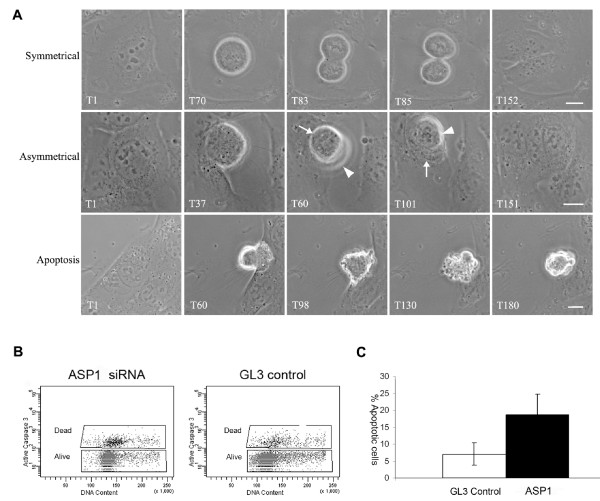
siRNA mediated ASPM induces misorientation of the plane of cell division, cytokinesis failure and increased apoptosis in U2OS cells. A. Panels showing phase contrast images of living U2OS cells taken from time-lapse movies. Time points are shown in the bottom left hand corner of each image. Top row. Normal symmetrical division of a GL3 siRNA treated control cell with the cleavage plane oriented perpendicular to the cell substrate (see Additional file 5). Scale bar = 10 μm. Middle row. ASP1 siRNA treated cell undergoing an asymmetric division with the mitotic spindle positioned perpendicular to the cell substrate. This division led to cytokinesis failure with the formation of a binucleate cell. Arrowhead shows the upper daughter cell moving out of the focal plane towards the observer as the cleavage furrow is formed parallel to the surface of the imaging dish. An arrow indicates the lower daughter cell still attached to the surface of the dish (see Additional file 6). Scale bar = 10 μm. Bottom row. Binucleated ASP1 siRNA treated cell undergoing apoptosis (see Additional file 7). Scale bar = 10 μm. B. Flow cytometric analysis of caspase-3 assayed 96 hours after ASP1 and GL3 siRNA treatment. An increase in the population of apoptotic (dead) cells is observed in ASP1 siRNA experiments. C. Histogram showing the mean percentage of apoptotic cells in ASP1 and GL3 siRNA caspase-3 assays. A 2.7 fold increase in the percentage of apoptotic cells in the ASP1 siRNA population was identified compared to the GL3 siRNA population. Standard deviation values for the mean are shown as vertical bars.